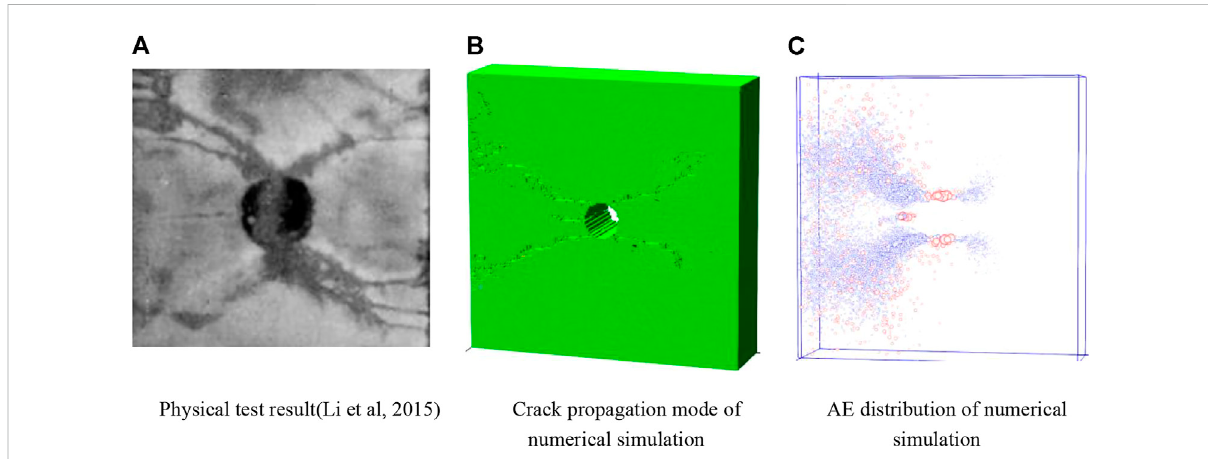
FIGURE 1 Comparison of numerical and experimental results for rock specimen with a pre-existing hole. (A) Physical test result (Li et al, 2015). (B) Crack propagation mode of numerical simulation (C) AE distribution of numerical